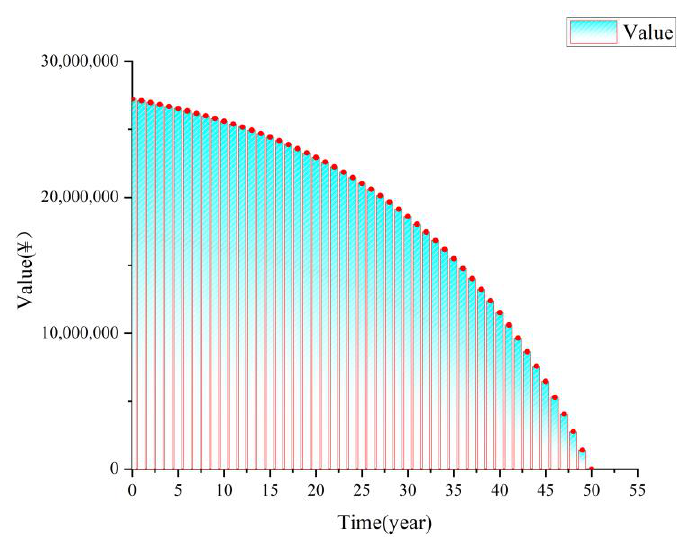
Figure 7. Depreciation over the useful life of the building.